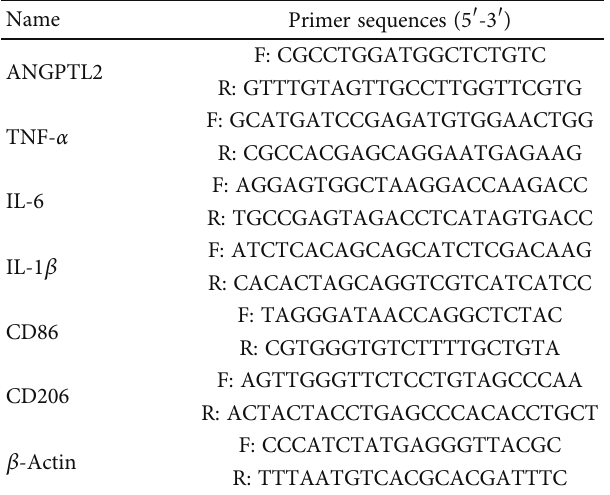
Table 1: The primer sequences in this study. Name Primer sequences (5 ′ -3 ′